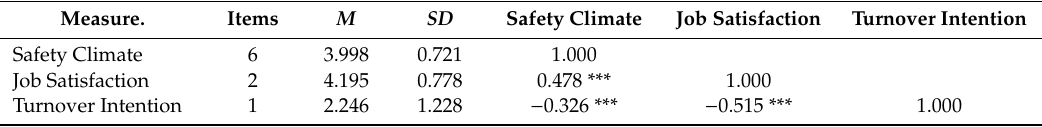
Table 2. Descriptive statistics and correlation matrix with full sample.